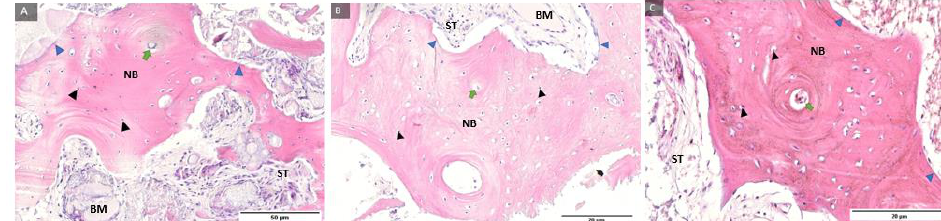
Figure 2. Examples of preparations of the test group ( A – C ) with labeled newly formed bone (NB), residual biomaterial (BM), soft tissue (ST), osteoblasts (blue filled triangle), osteocytes (black filled triangle), and Howship lacunae in the bone bed with a blood vessel (green arrow). Magnification: 100, 200, 400× .